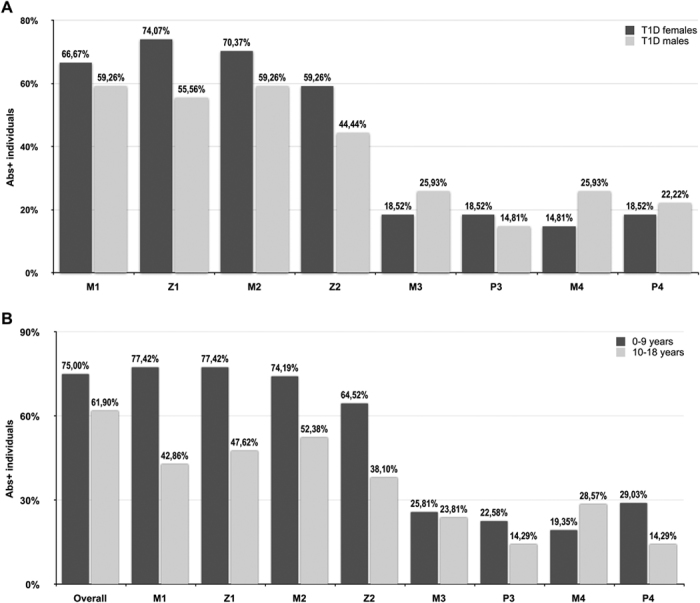
Age/sex-related prevalence of Abs against MAP, proinsulin and ZnT8 homologous epitopes in T1D at-risk subjects.Percentage of children with Abs positivity to selected epitopes upon single-peptide analysis: MAP3865c133–141 (M1); ZnT8186–194 (Z1); MAP3865c125–133 (M2); ZnT8178–186 (Z2), MAP1,4αgbp157–173 (M3); PI64–80 (P3); MAP2404c70–85 (M4); PI46–61 (P4). (A) Sex-related Abs status of positive individuals is indicated by dark grey bars for females and light grey bars for males. (B) Analysis performed for 0–9 (dark grey bars) and 10–18 (light grey bars) year-old groups. The first column pair indicates reactivity to any of the analysed peptides.